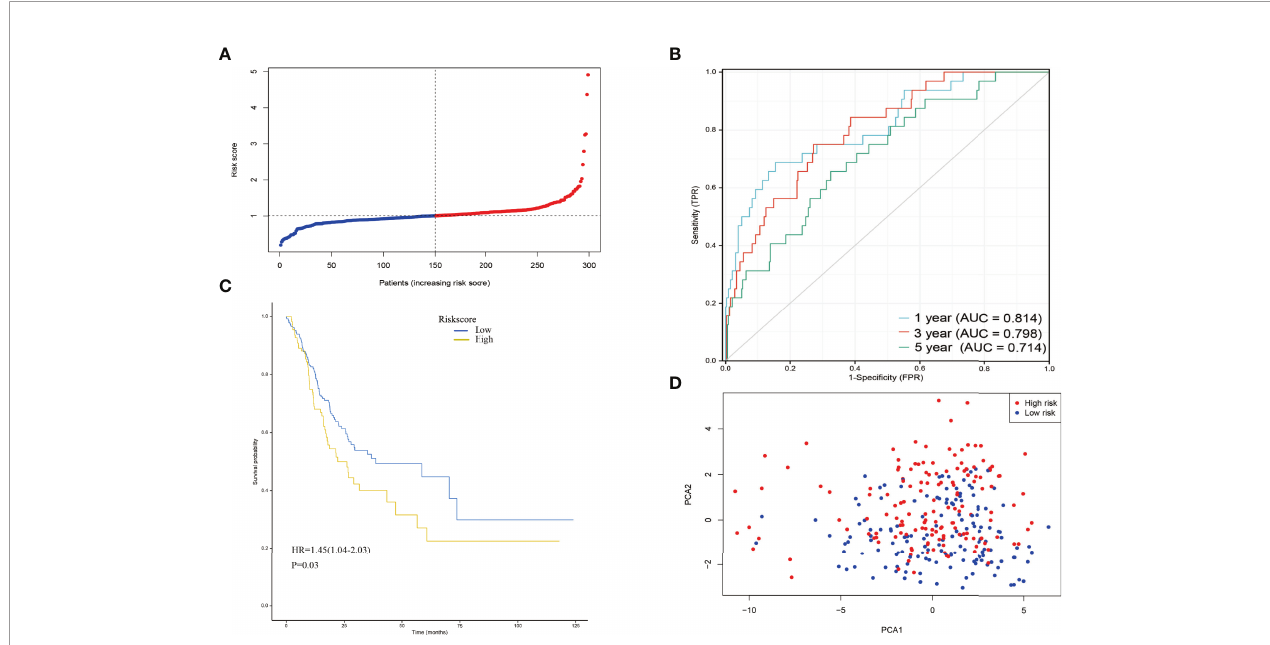
FIGURE 4 | (A) The distribution and median value of the risk scores in the derivation cohort. (B) AUC of time-dependent ROC curves veri fi ed the prognostic performance of the risk score in the derivation cohort. (C) Kaplan-Meier curves for the OS of patients in the high-risk group and low-risk group in the derivation cohort. (D) PCA plot of the derivation